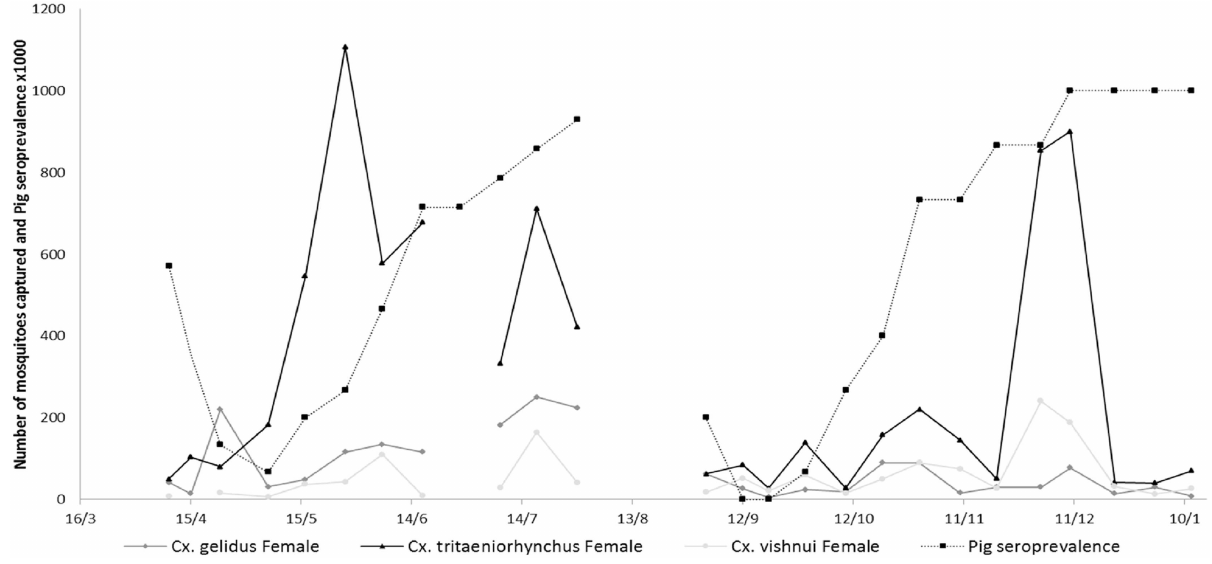
Fig 4. Evolution of the number of trapped mosquitoes and pig seroconversion dynamic during the two survey